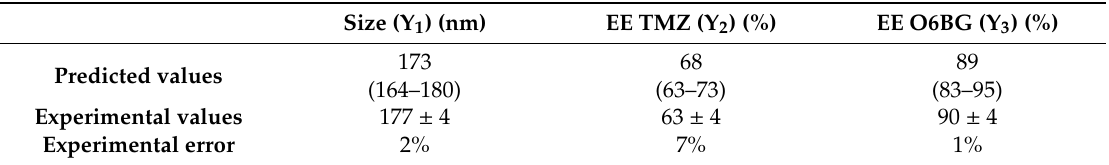
Table 5. Validation of the model by comparing the predicted values with the observed experimental values. The experimental data is given as the mean ± SD ( n = 3).